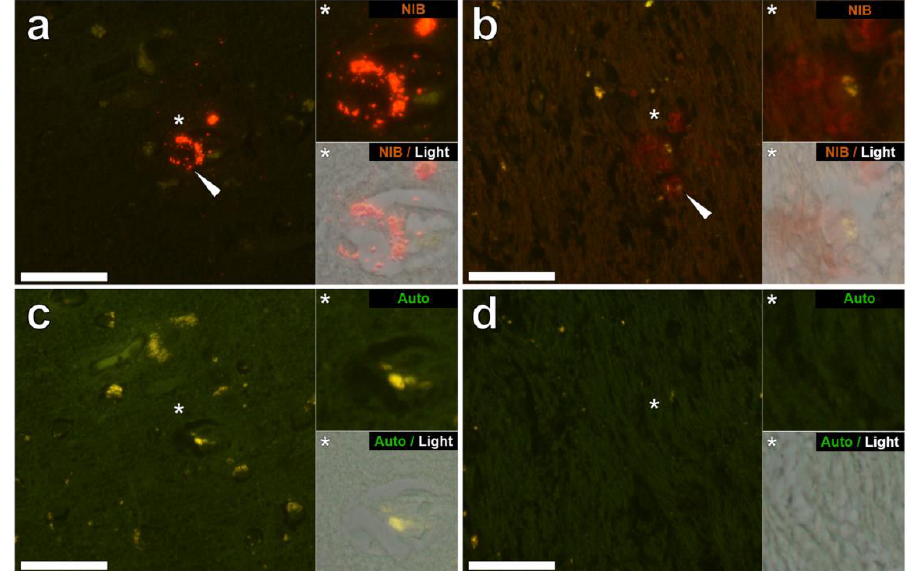
Figure 1. Extracellular aluminium in the frontal lobe and hippocampus of a 56-year-old male donor (MS274), diagnosed with RRMS. ( a ) Intense orange fluorescence (white arrow) indicating punctate deposits of aluminium was observed in the perivascular region of a small blood vessel in the white matter of the frontal lobe, in close proximity to lipofuscin, identified by yellow fluorescence. ( b ) Extracellular deposits of aluminium, identified as diffuse orange-red fluorescence, appear co-deposited with lipofuscin (white arrow) in white matter adjacent to the parahippocampal gyrus. ( c , d ) Autofluorescence of serial sections confirms the identity of aluminium in ( a , b ) respectively. Upper and lower panels depict magnified inserts of the fluorescence channel and bright field overlay. Magnification ×400, scale bars: 50 μm.